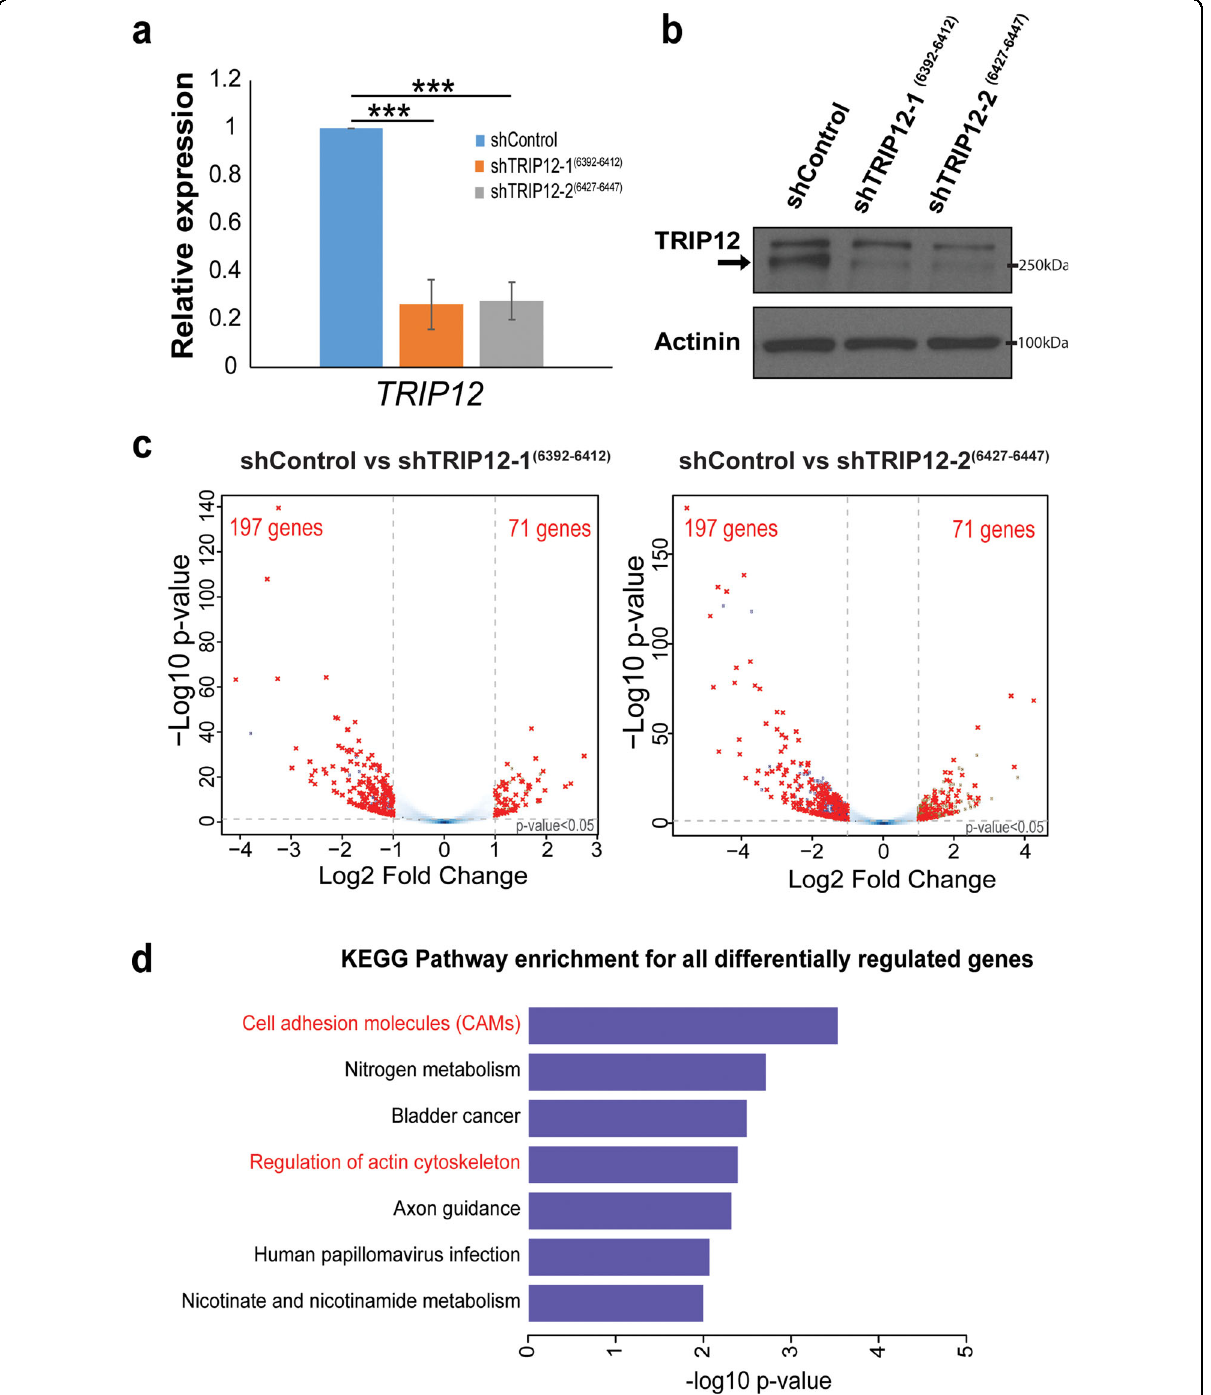
Fig. 2 RNA-seq reveals cell adhesion molecules as the most signi fi cant pathway regulated by TRIP12. a Relative expression of TRIP12 mRNA in MCF10A cells stably depleted of TRIP12. Relative expression levels were normalized to Actin mRNA levels and data quanti fi ed relative to shControl. ( N = 3). Data represents means ± SD. *** p value < 0.001. b TRIP12 and Actinin protein levels in MCF10A cells stably depleted of TRIP12. Actinin serves as a loading control. Arrow indicates the TRIP12 band. ( N = 3). c Volcano plots showing the differentially regulated genes upon TRIP12 depletion in MCF10A for shTRIP12-1 (6392 – 6412) (left panel) and shTRIP12-2 (6427 – 6447) (right panel), as compared to shControl. Differentially regulated genes were identi fi ed using the criteria: FDR < 0.05 and |Log2 fold change| >1. Dots marked in red represent the overlap of differentially regulated genes between shTRIP12-1 (6392 – 6412) and shTRIP12-2 (6427 – 6447) . ( N = 2 for each shRNA). d KEGG pathway analysis for all differentially regulated genes which overlap between shTRIP12-1 (6392 – 6412) and shTRIP12-2 (6427 – 6447) shown in ( c ). Pathways related to EMT are highlighted in